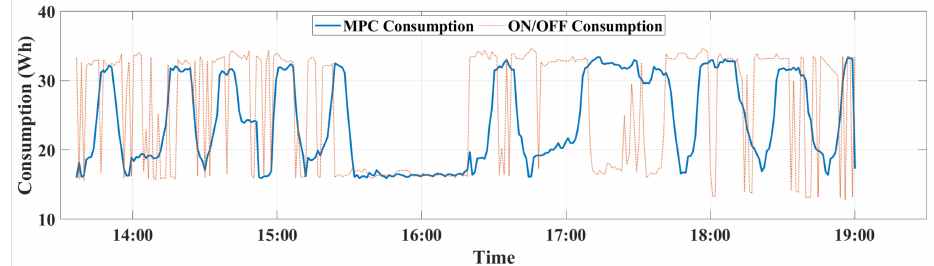
Figure 14. Energy consumption variation of the ventilation system during control for both ON/OFF and MPC